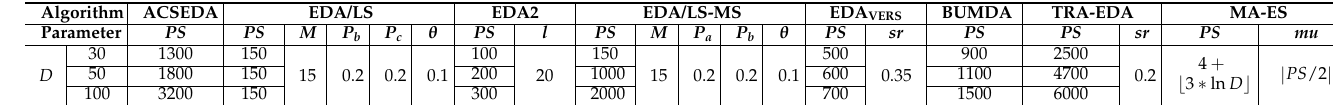
Table 1. Parameter settings of ACSEDA and the compared